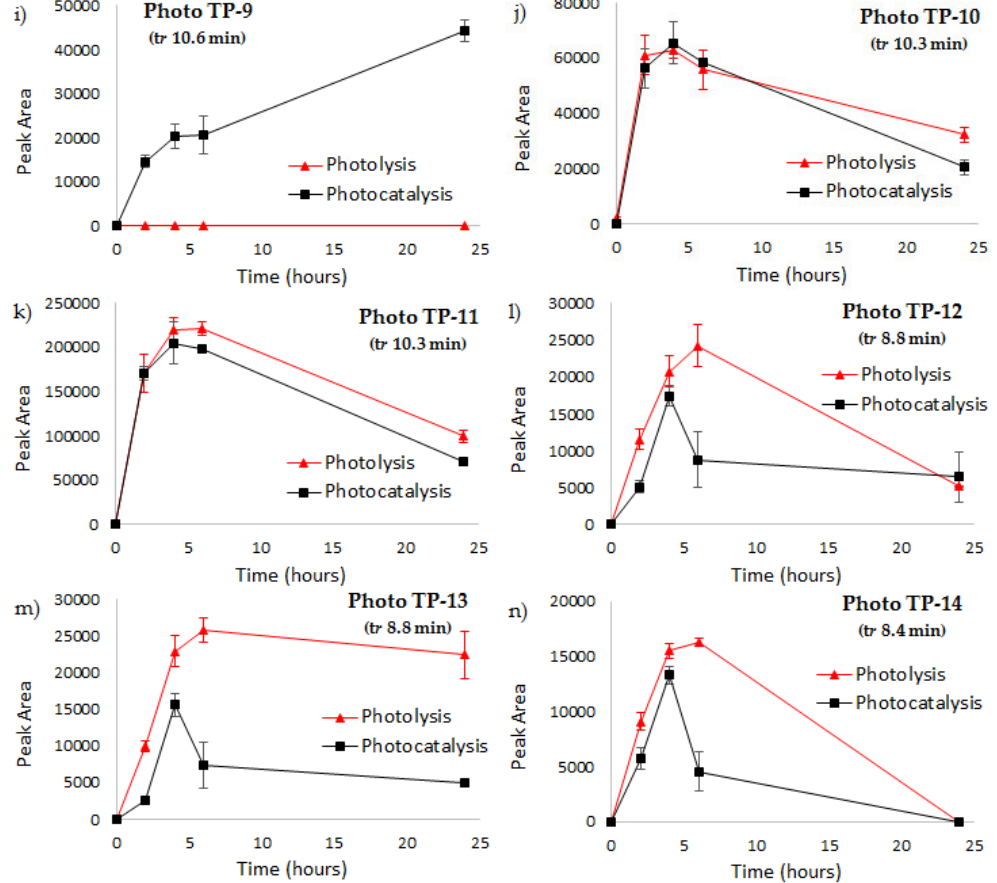
Figure 3. Time profiles of detected Photo TPs during investigated treatments, namely, photolysis (only UV light) and photocatalysis (UV light in the presence of HApTi). Error bars refer to standard deviation of triplicate samples.